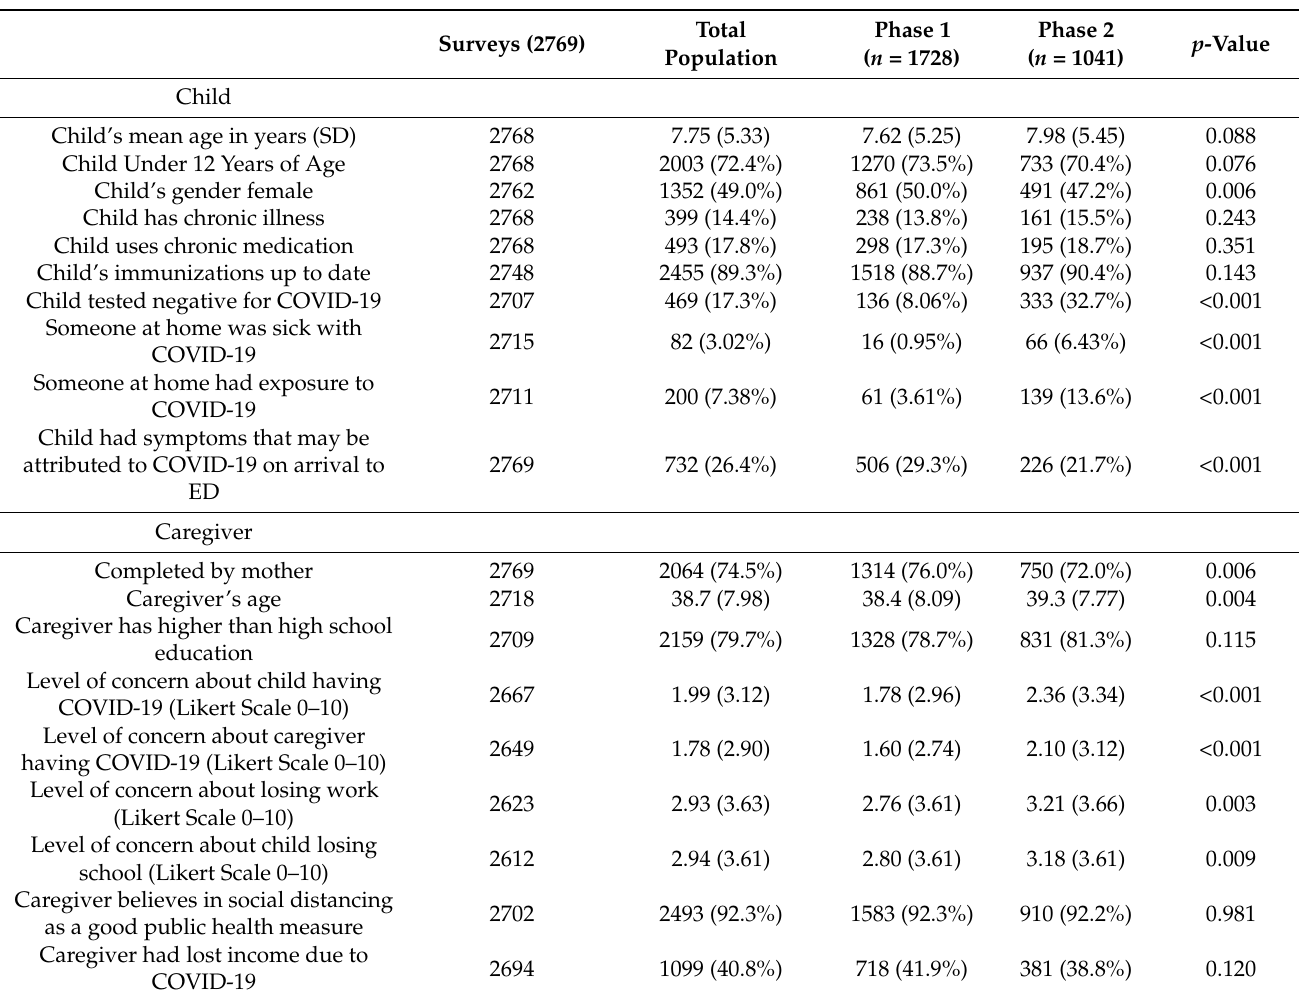
Table 1. Characteristics of the survey population during the first phase (March–May 2020) and second phase (December 2020–March 2021). SD = Standard